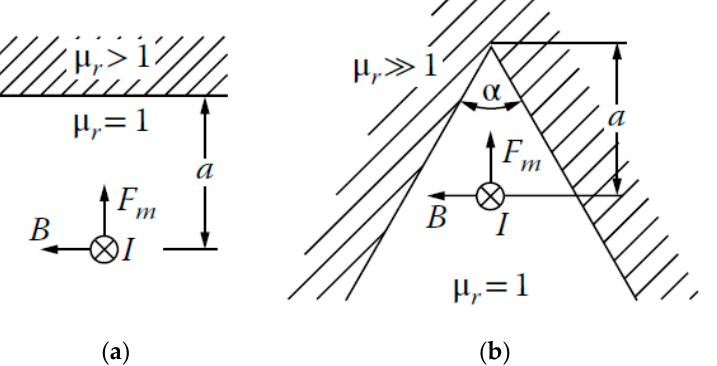
Figure 1. Principle of arc attraction by ferromagnetic plates: ( a ) straight front side; ( b ) V-shaped front side [3].